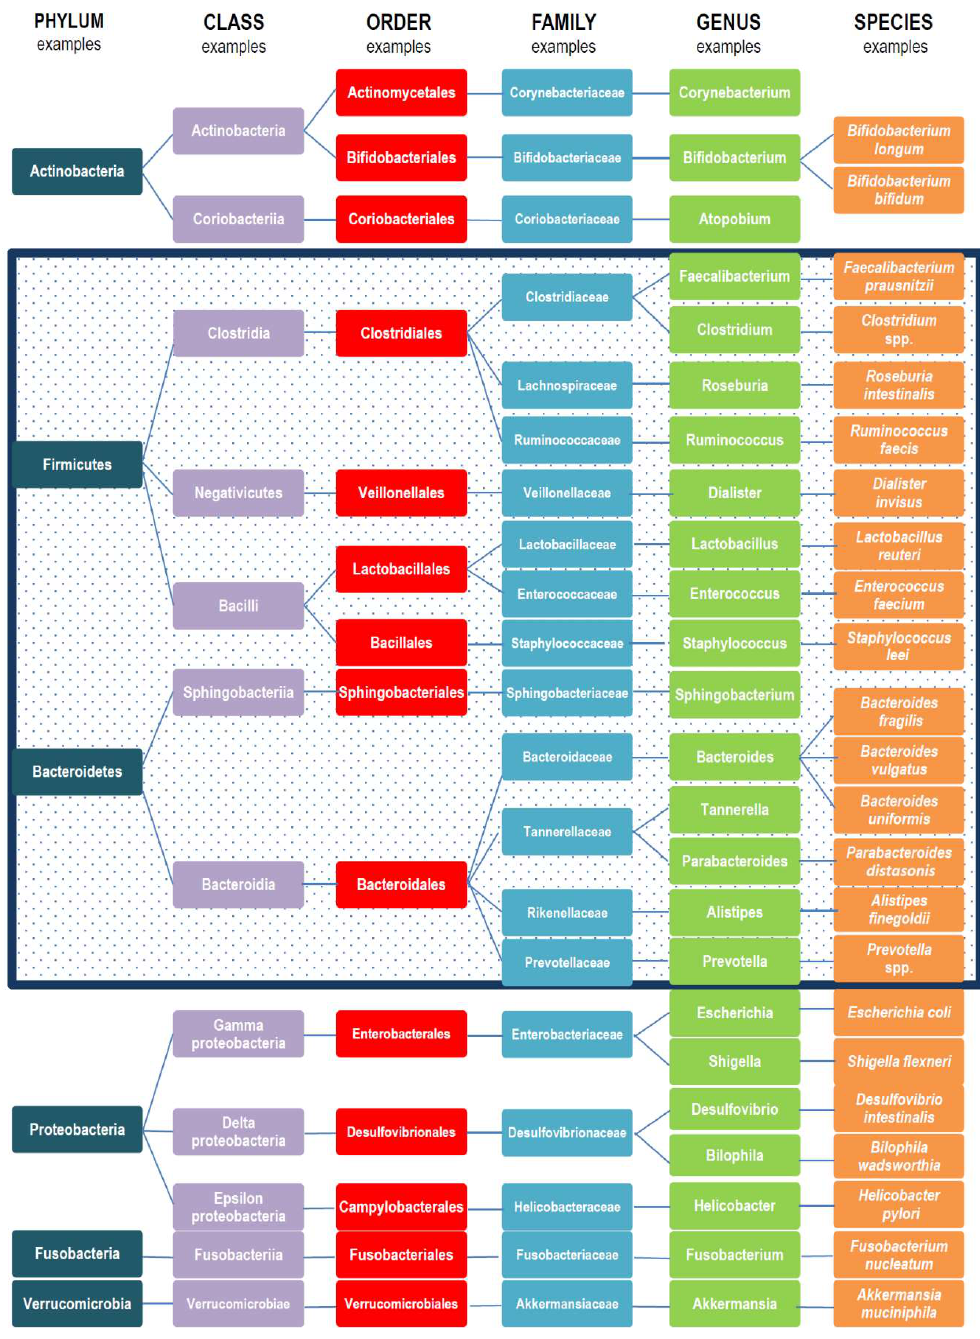
Figure 1. Examples of taxonomic gut microbiota composition. In the box are cited examples of bacteria belonging to Phyla Firmicutes and Bacteroidetes, representing 90% of gut microbiota.